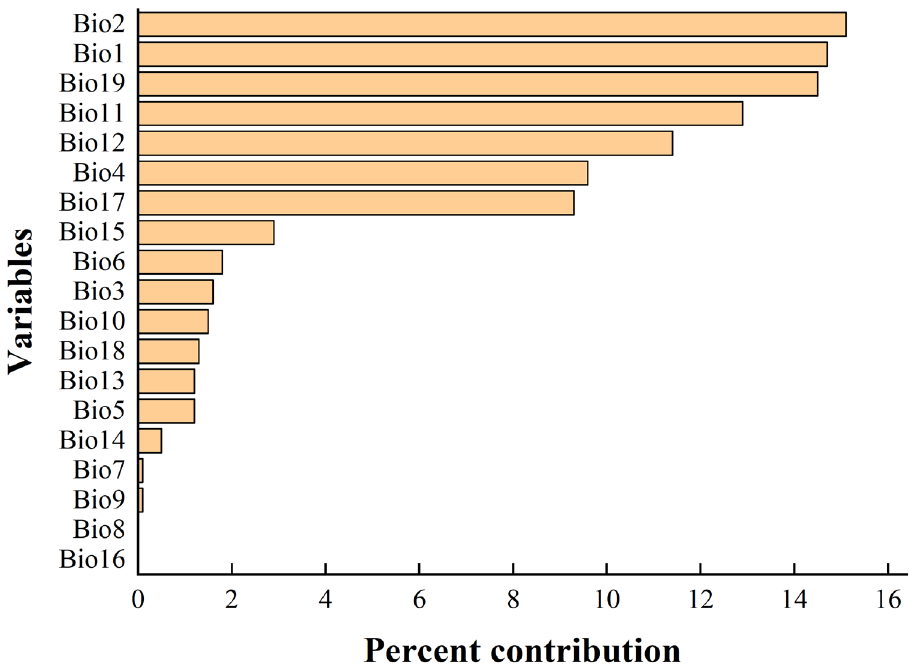
Figure 10. Percent contribution of 19 environmental variables to N. californicus